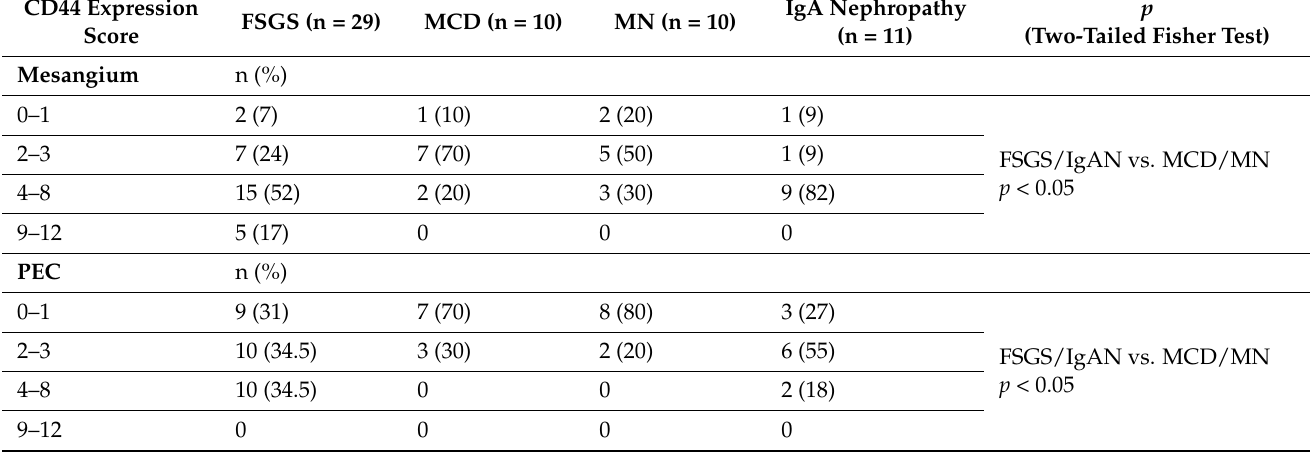
Table 1. CD44 expression score in patients with different